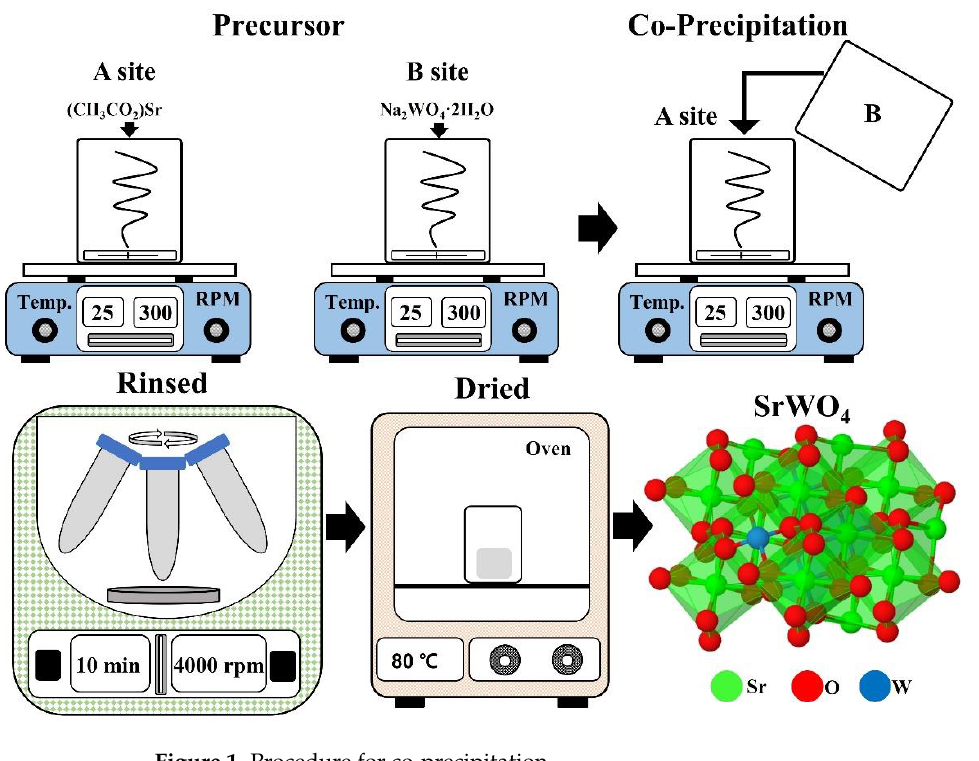
Figure 1. Procedure for co-precipitation.